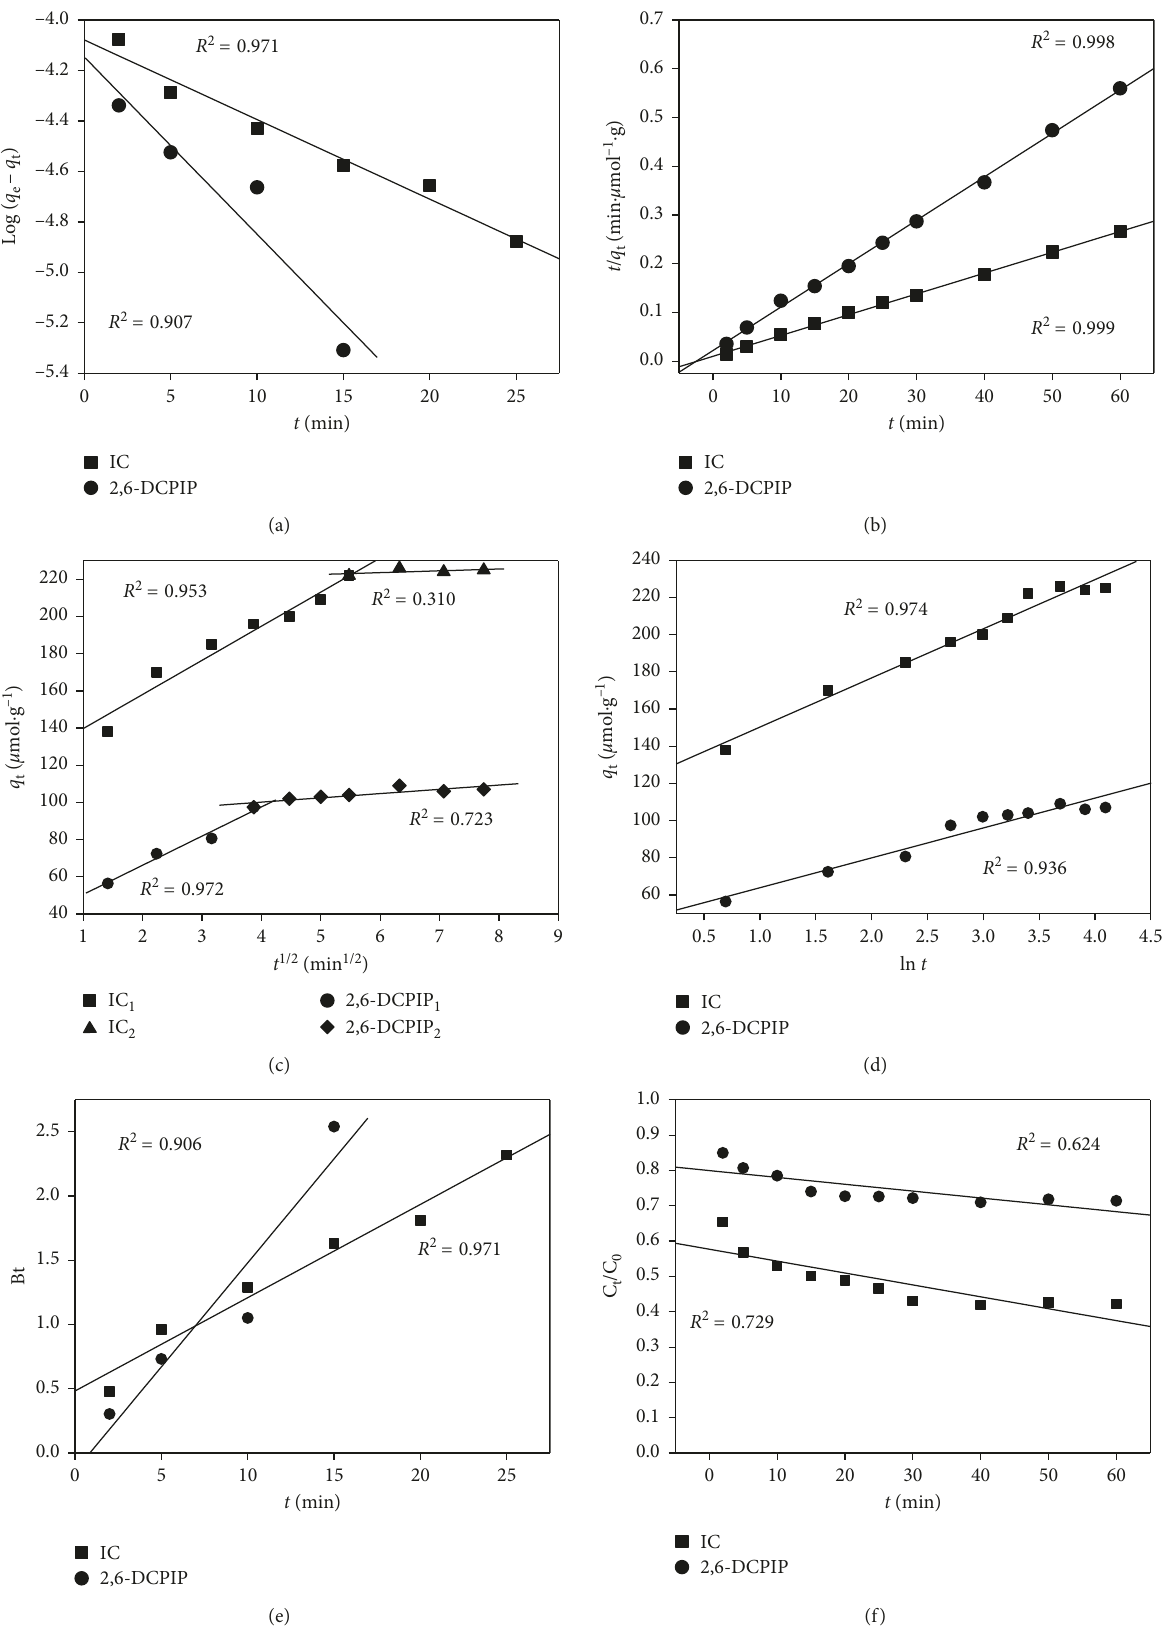
Figure 13: Linear regression of adsorption kinetics of (a) pseudo-first-order, (b) pseudo-second-order, (c) intraparticle diffusion, (d) Elovich, (e) Boyd, and (f) external mass